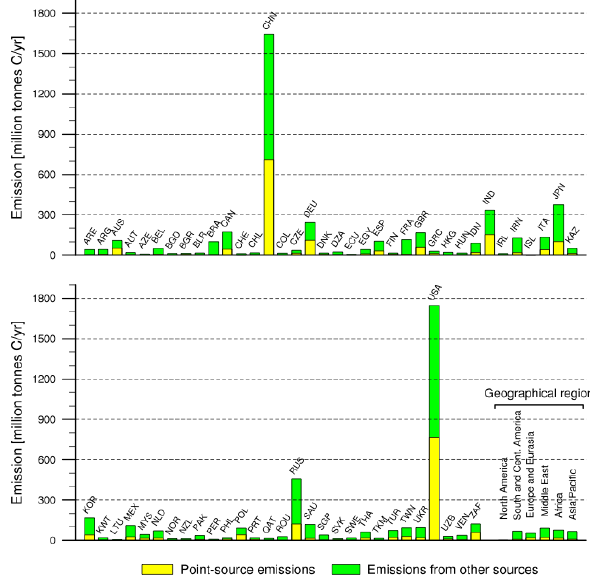
Fig. 2. National and regional total emission estimates for the year 2006. The yellow portion indicates emissions from point sources, and green indicates emissions from other sources (non-point). National and regional total point-source emissions (yellow) were calculated using the CARMA power plant data shown in Figure 1. The non-point source emissions (green) were estimated by the residual of the total emission minus the point source emissions. Values are given in units of Megatonne carbon year − 1 .